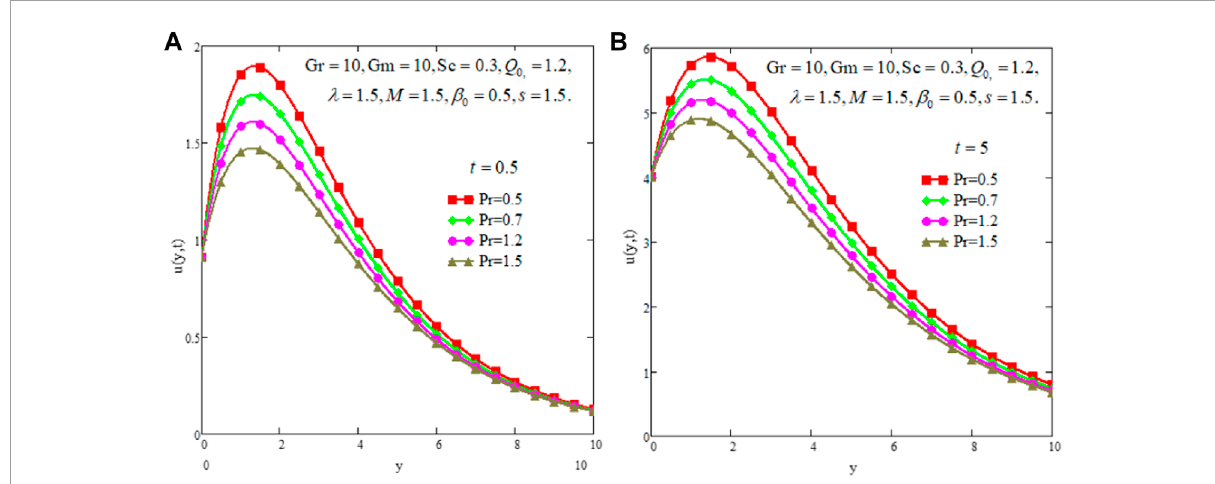
FIGURE 4 Velocity due to Pr for small time (A) and for large time (B) .